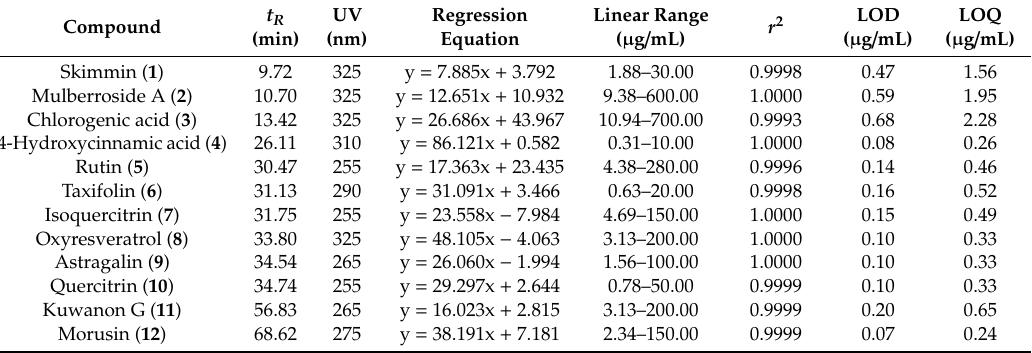
Figure 1. Chemical structures of the 12 marker compounds from the Morus samples. Table 1. Regression equation, linear range, correlation coefficient (r 2 ), limit of detection, and limit of quantification of the marker compounds .